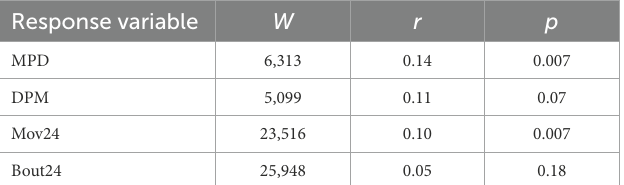
TABLE 6 Mann–Whitney U test comparing response variables (MPD, DPM, Mov24, and Bout24) between road interactions and no road